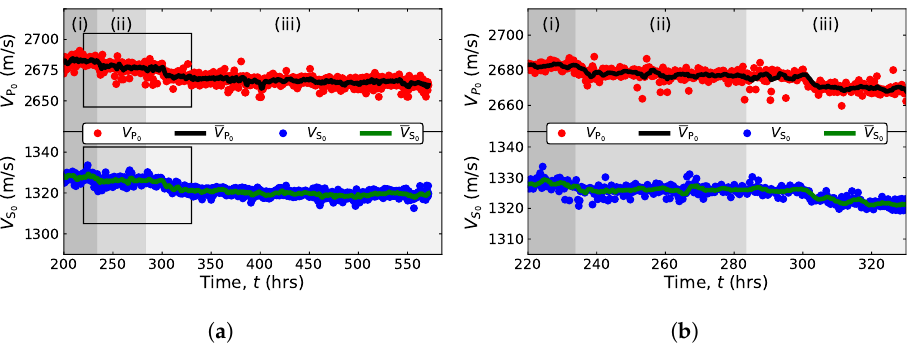
Figure 9. PT measured P-wave velocity ( V P and its averaged namesake V P ) and S-wave velocity 0 0 ( V P and its averaged namesake V P ) versus time t at 500 kHz. Roman numbering combined with 0 0 the grayscale background indicates the respective phases of fluid exposure: Phase (i), Phase (ii), and Phase (iii). Rectangles in ( a ) indicate x- and y-limits in ( b ). Rectangles in ( a ) indicate x- and y-limits in ( b ). Ten measurements were averaged.